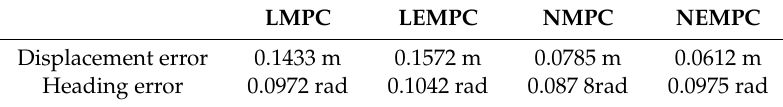
Figure 6. The computation time when velocity is 2 m / s. ( a ) LMPC. ( b ) LEMPC. ( c ) NMPC. ( d ) NEMPC. Table 2. The maximum absolute values when velocity is 2 m / s.